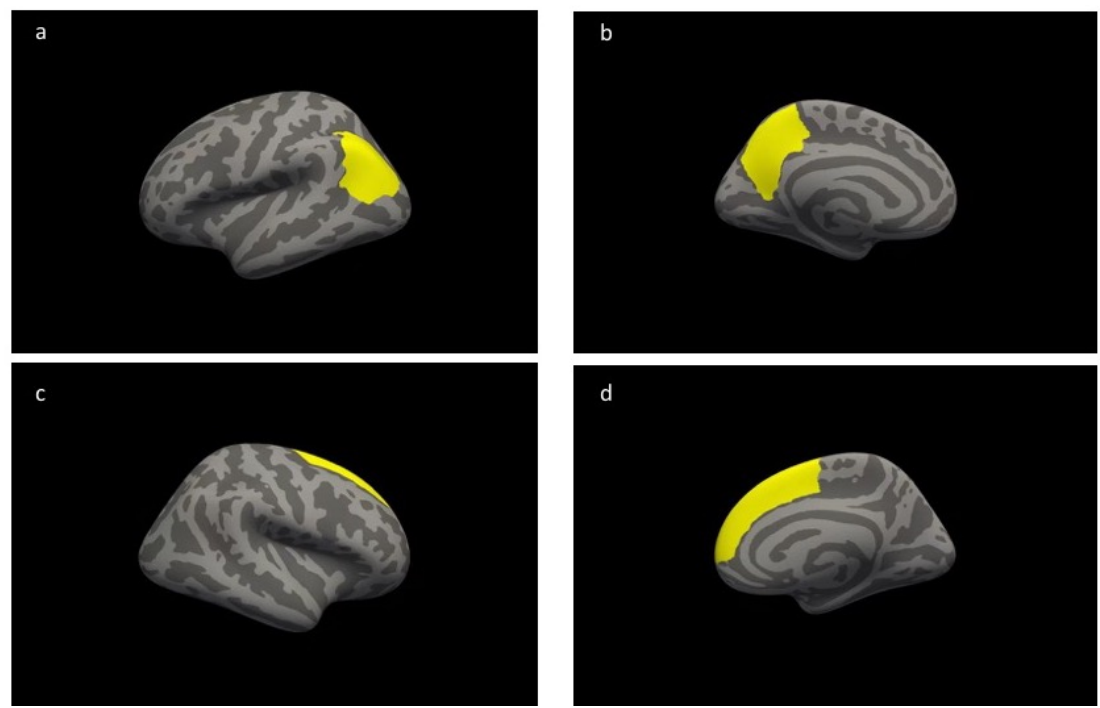
Figure 2. Compared with the control group, the athlete group showed greater cortical thickness in the colored brain regions based on the parcel-wise analysis: ( a ) indicates the left inferior parietal lobe, ( b ) indicates the left precuneus, and ( c , d ) the lateral view of the inferior view of the right superior frontal lobe.